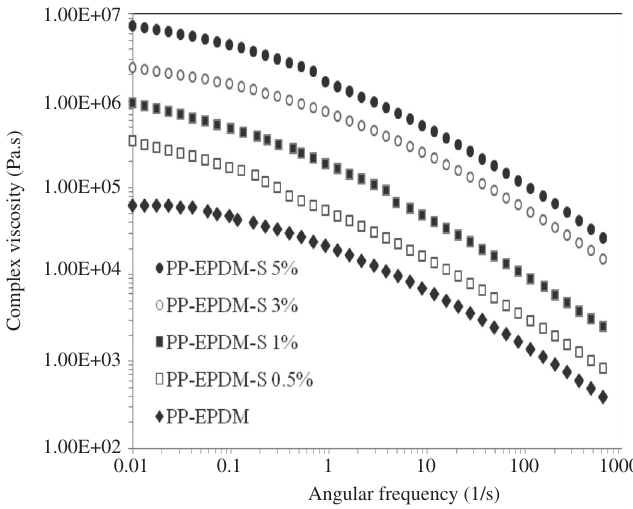
Figure 4 Complex viscosity vs. angular frequency of PP/EPDM and its nanocomposites reinforced with SWNT.